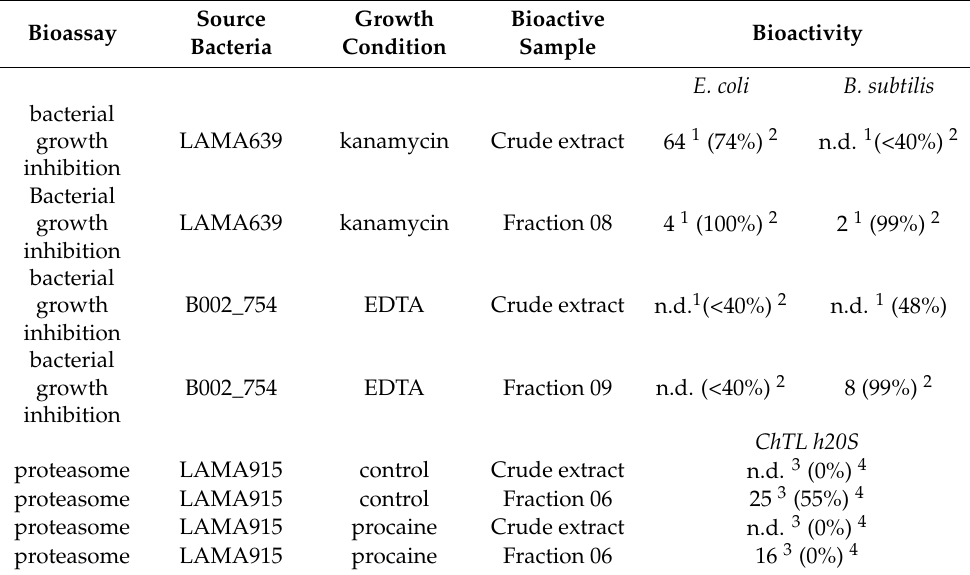
Table 1. Hits selected from the biological screenings carried out with the prepared elicited deep-sea bacterial chemical library. Crude extract samples from which the chromatographic fraction was obtained were included for